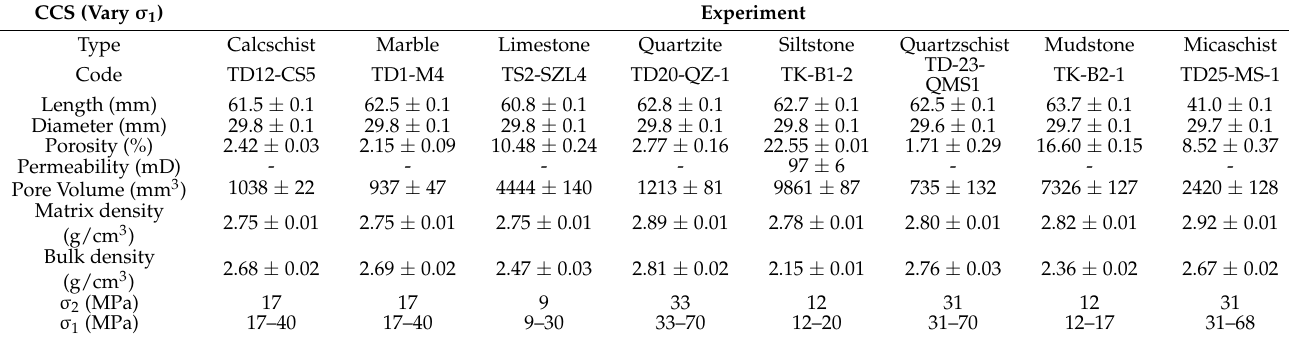
Table 5. Properties of the core samples used in experimental series D: CCS tests (varying σ 1